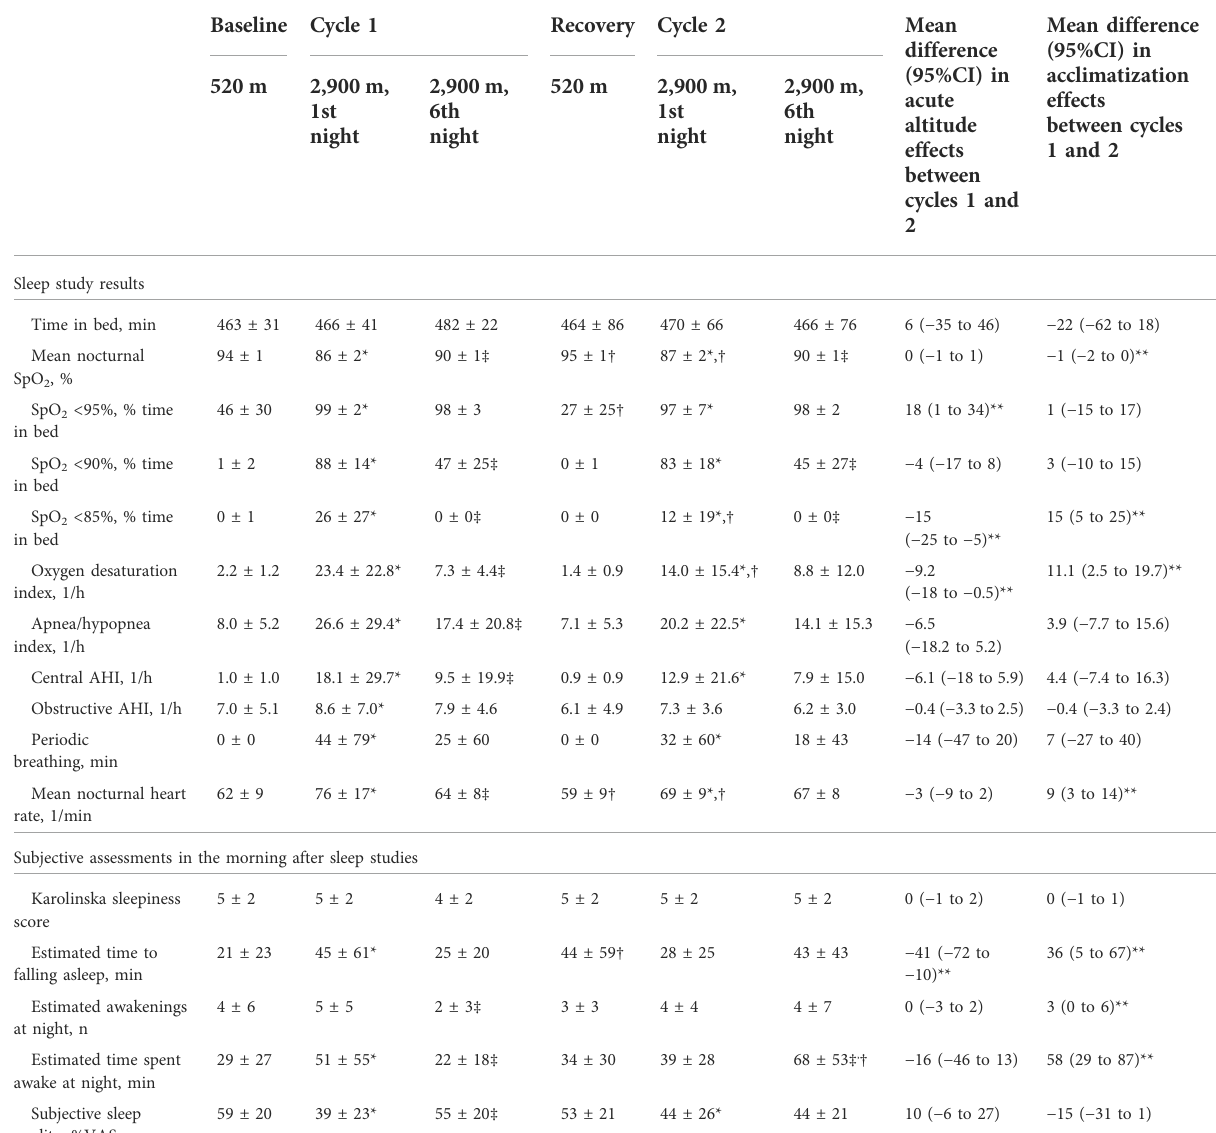
TABLE 2 Sleep studies and subjective sleep assessment. Baseline Cycle